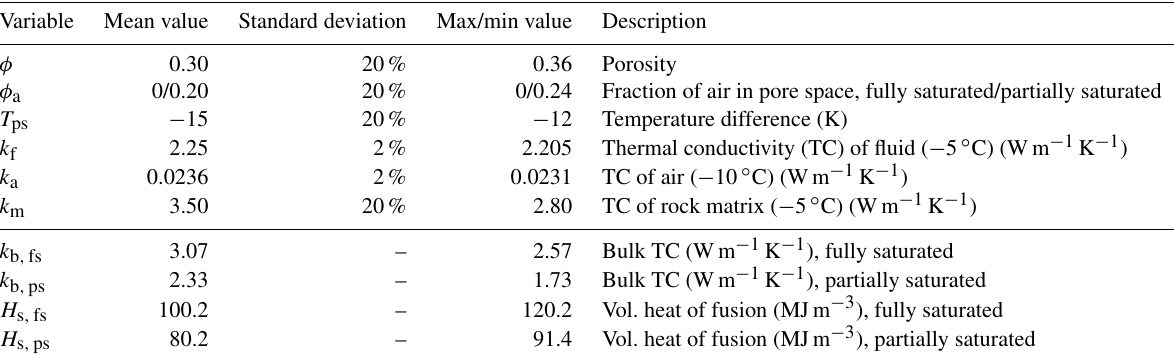
Figure 7. North–south transect created from SkyTEM resistivity grid in Workbench. Transect location is shown in inset map (A to B) in upper left corner. Mean resistivity maps were created using a 1km search radius (2 × line spacing) and 5m elevation slices. Subsurface boundaries are approximated and interpretations based on Mikucki et al. (2015). The subsurface boundary between brine-saturated sediments and permafrost is defined using a resistivity threshold of 100 (cid:127) m. Table 1. Input values for Eq. (1) through Eq. (4) and Monte Carlo analysis to calculate permafrost ages. Max/min value column shows values within 1 standard deviation resulting in the oldest permafrost